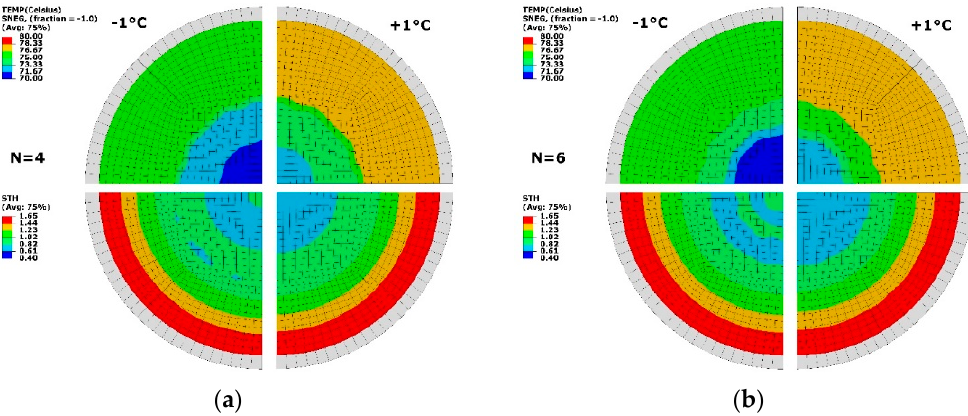
Figure 11. Temperature (TEMP, top) and thickness (STH, bottom) under temperature perturbation. ( a ) N = 4 , ( b ) N = 6.